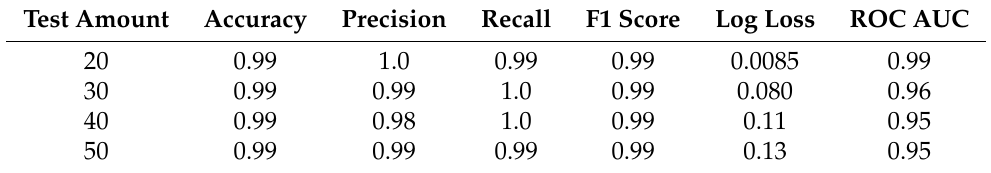
Table 23. Key logging DT test data